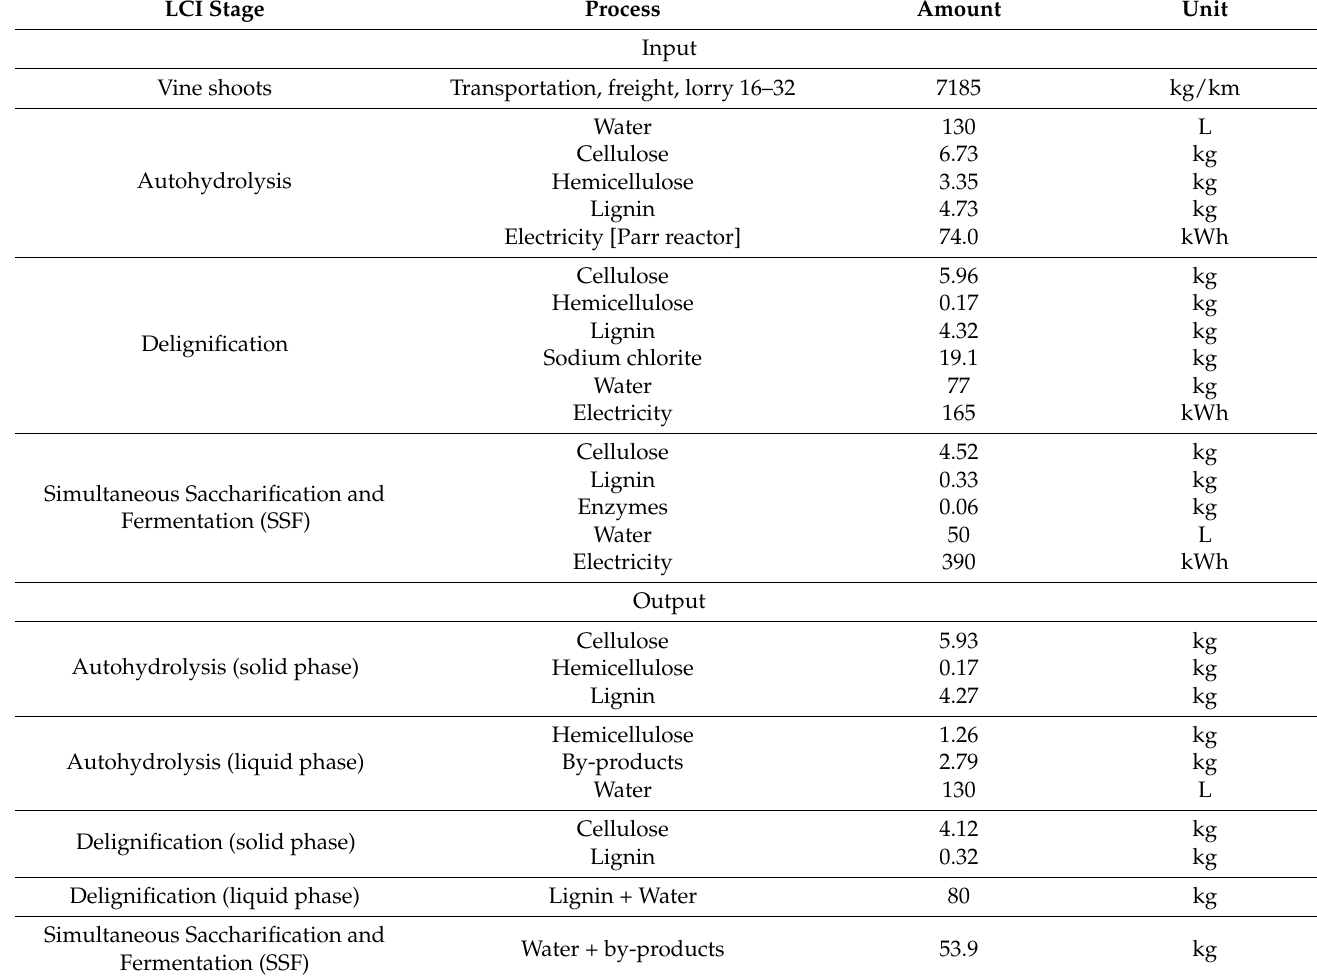
Table 1. Life cycle inventory for bioethanol production (1 kg).